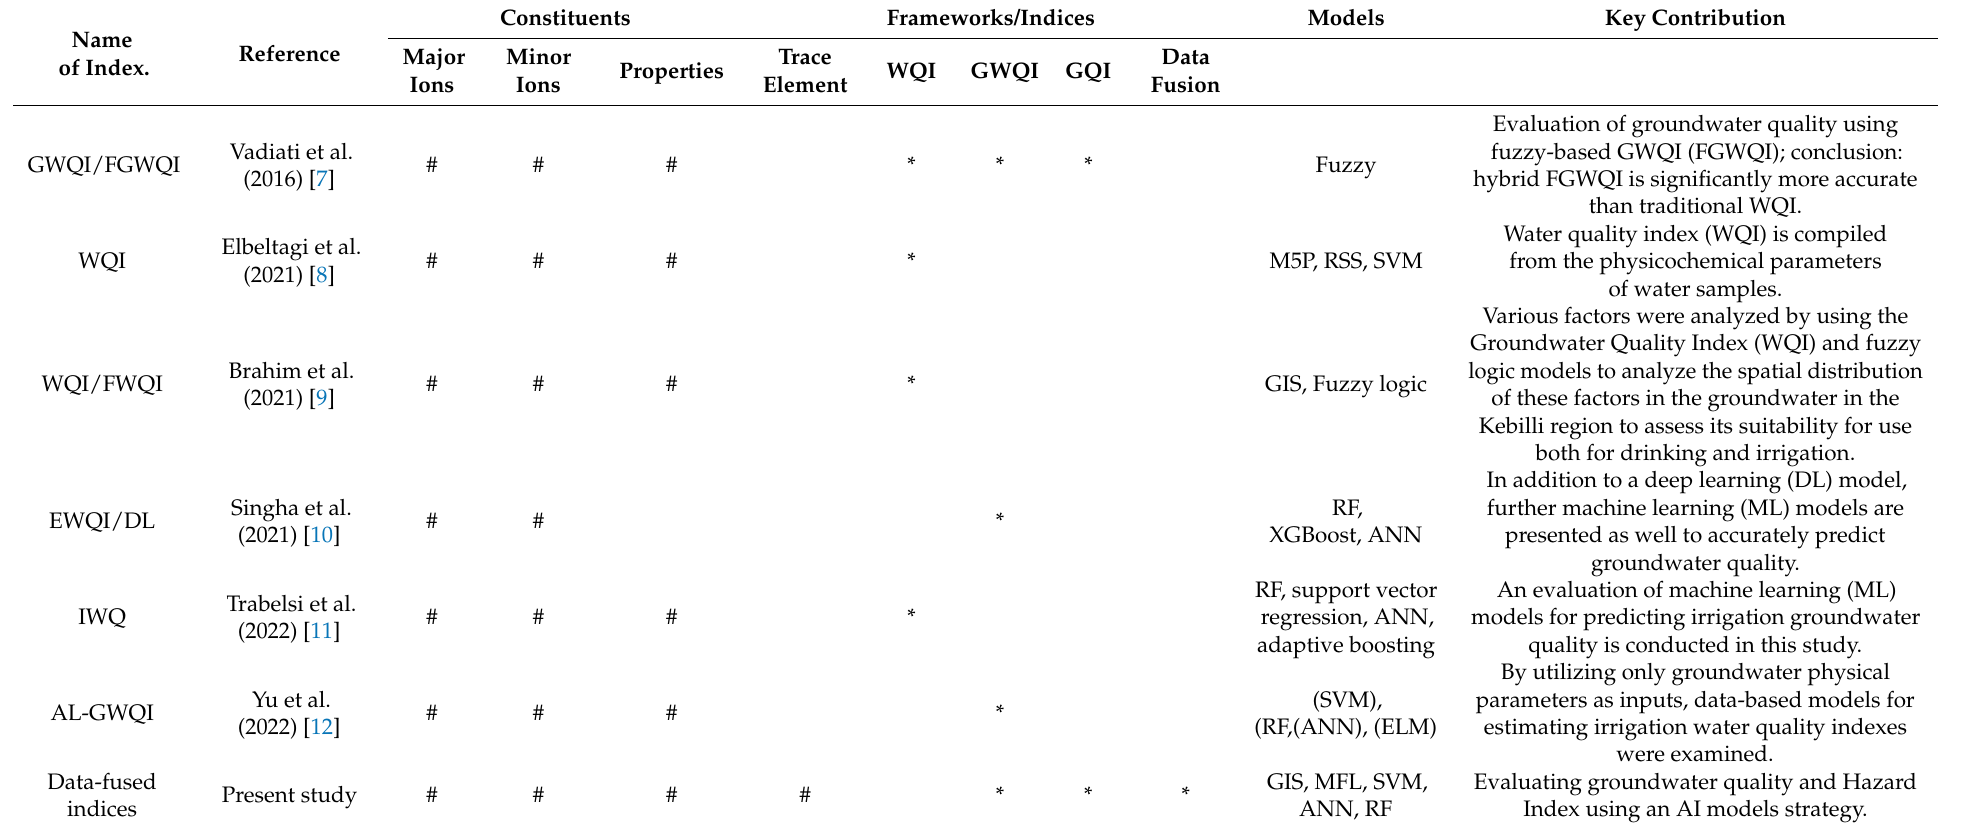
Table 1. Different types of groundwater quality indicators developed around the